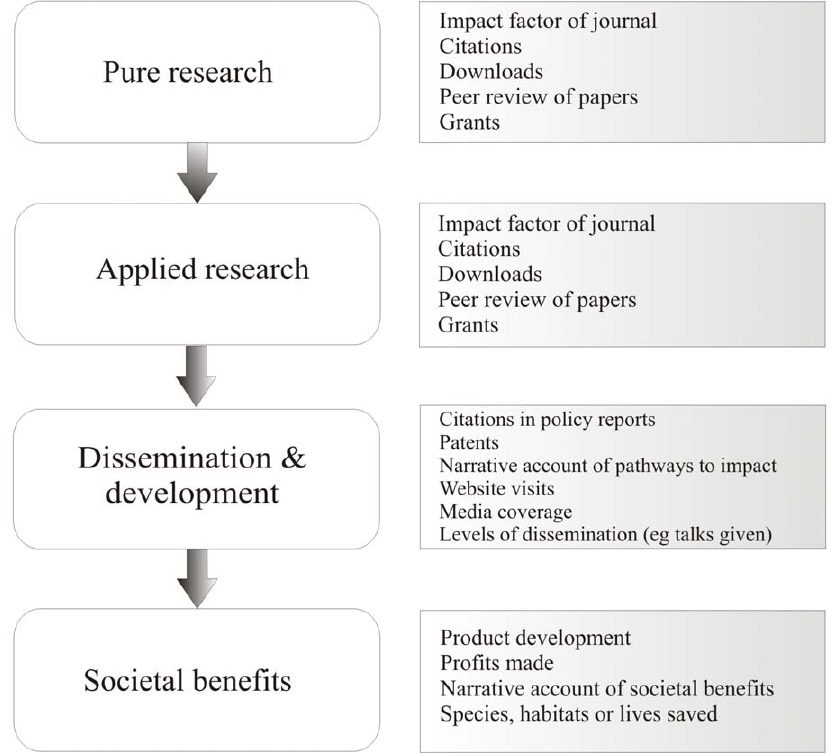
Figure 1. Main components of the progression of science into practice and societal benefits (left), with some existing measures of impact and quality (right).